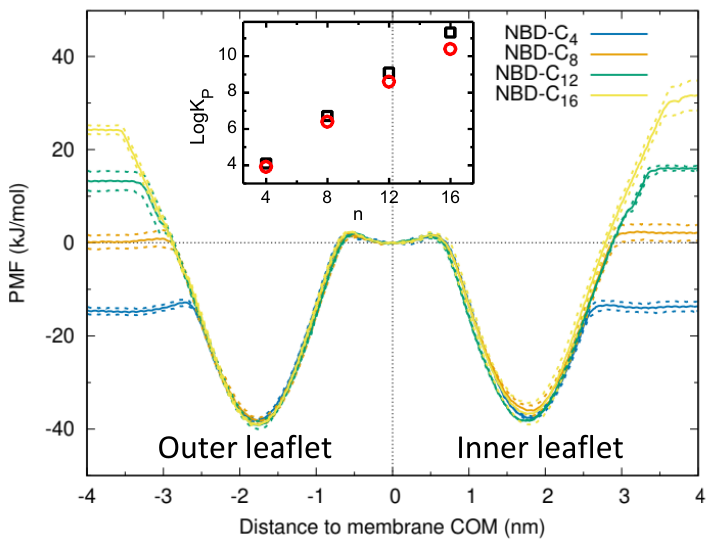
Figure 5. PMF profiles for the interaction of NBD–Cn with the asymmetric lipid membrane (without P–gp). The error estimates are shown by the dotted lines. The inset shows the dependence of the partition coefficient with the length of the amphiphile alkyl chain. See text and Table 1 for